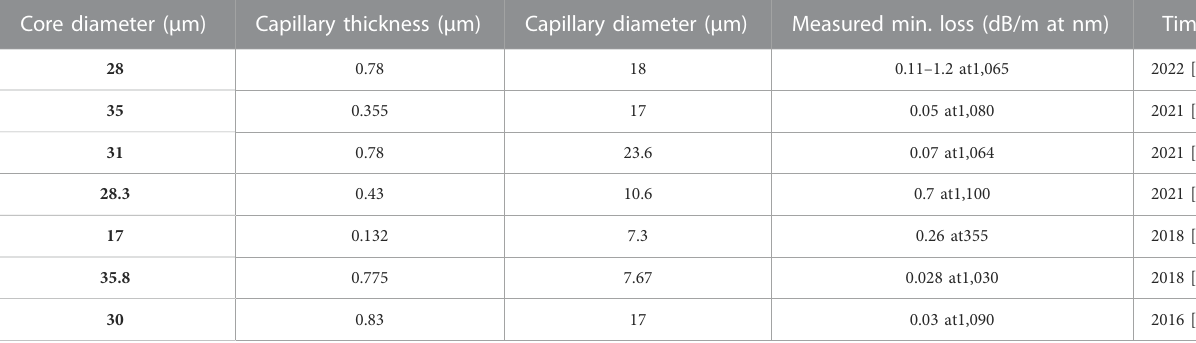
The bold values are the core diameter of the